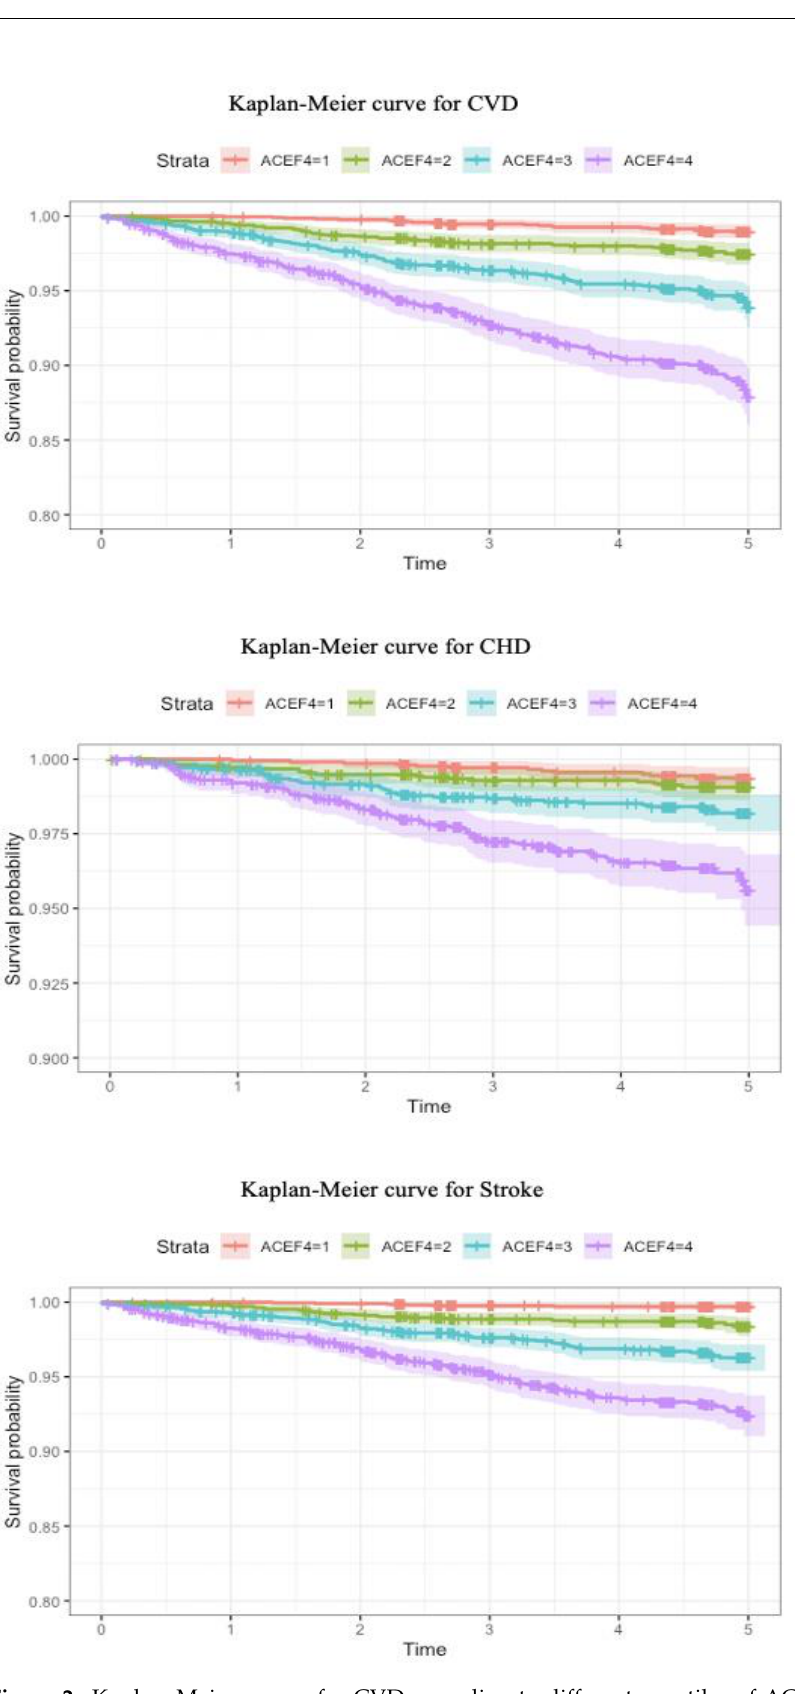
Figure 2. Kaplan–Meier curves for CVD according to different quartiles of ACEF4 = 1: red line represents 1st quartile, ACEF4 = 2: green line represents 2nd quartile, ACEF4 = 3: blue line represents 3rd quartile, and ACEF4 = 4: purple line represents 4th quartile. The time unit of the abscissa is years.